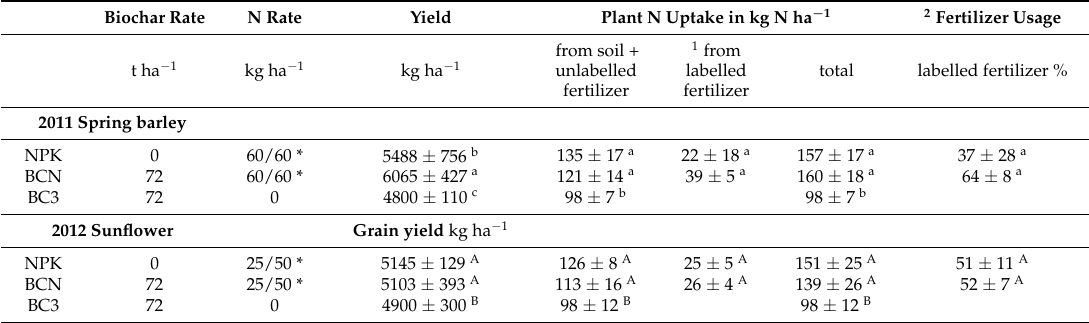
Table 1. Above ground, total plant biomass-yield, nitrogen uptake and fertilizer usage (%) in barley and sunflower following biochar soil application in 2011 (mean ± 1 standard deviation). Different letters within a column indicate significant differences between treatment means within single years ( p < 0.05; n = 4, using Student’s t -test, when only two treatments; ANOVA when 3 treatments; all values based on dry weight